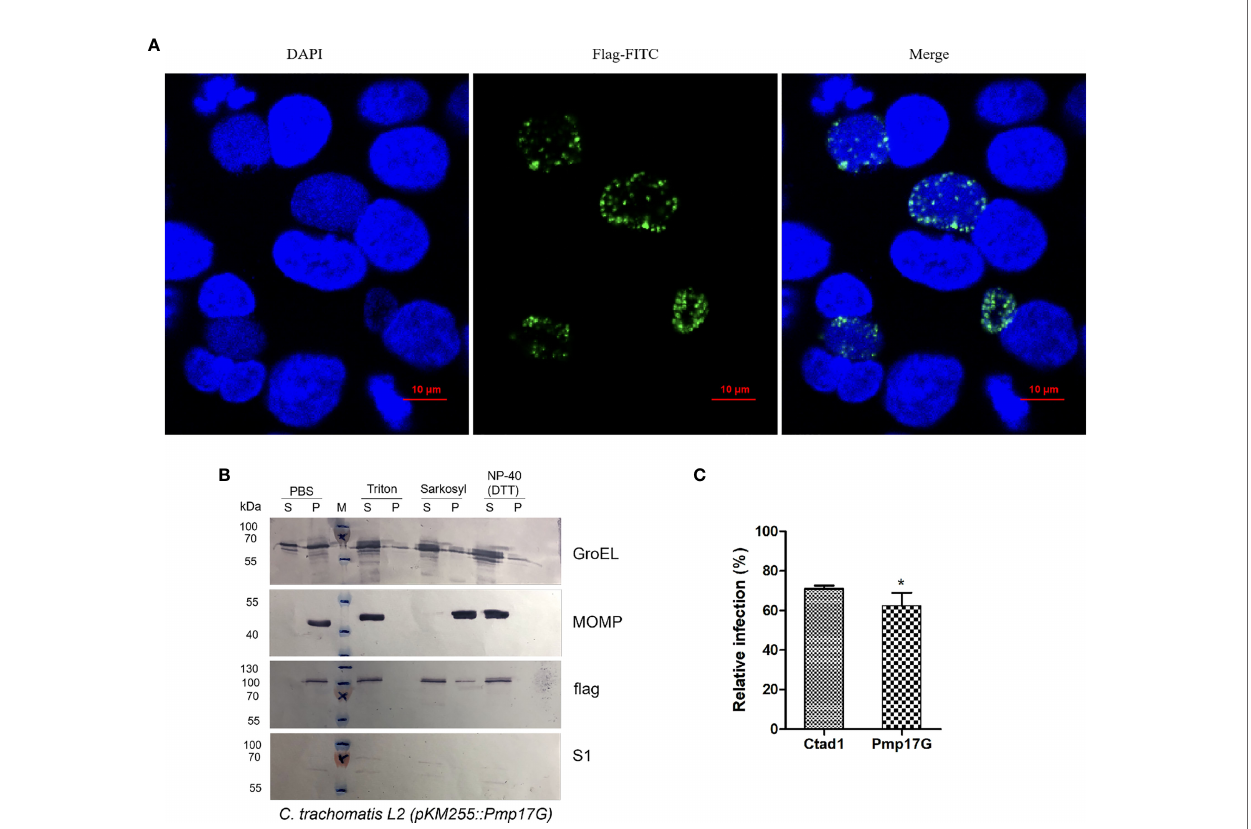
FIGURE 2 | Expression of C.psittaci -speci fi c PmpG17 upregulated C . trachomatis infection. (A) Identi fi cation of C. psittaci -speci fi c PmpG17 in C. trachomatis L2 strain by indirect immuno fl uorescence at 24 hpi. (B) Expressions of C psittaci -speci fi c PmpG17 were located both on outer membrane and cytoplasm of elementary bodies by Western blots. GroEL, a heat-shock protein located both on outer membrane surface and cytoplasm, MOMP, an outer membrane protein, and S1 protein, an intracellular protein of C. trachomatis L2 as the control group. Elementary bodies of C. trachomatis L2 (pMK255:: pmp17G ) were treated with PBS, 1% Triton-X 100, 2% Sarkosyl or N-40 with DTT, respectively. Pellet (P) and supernatant (S) fractions were prepared by centrifugation and incubated with anti-S1, anti-MOMP, anti- GroEL1 and anti- fl ag antibodies, respectively. (C) HEp-2 cells were preincubated with 200 m g/ml of recombinant Pmp17G or Ctad1 as a positive control. Afterwards, above cell cultures were inoculated with C. trachomatis L2 (pMK255:: pmp17G ) at an MOI of 5 for 24 hours. IFUs were quanti fi ed as above described. Relative infection (%)=(IFUs of the treated group/IFUs of the PBS group)×100. Statistical analysis was performed by one-way ANOVA, and the data from 3 independent experiments were expressed as the means ± SD. Asterisks indicate statistical signi fi cance: *p <